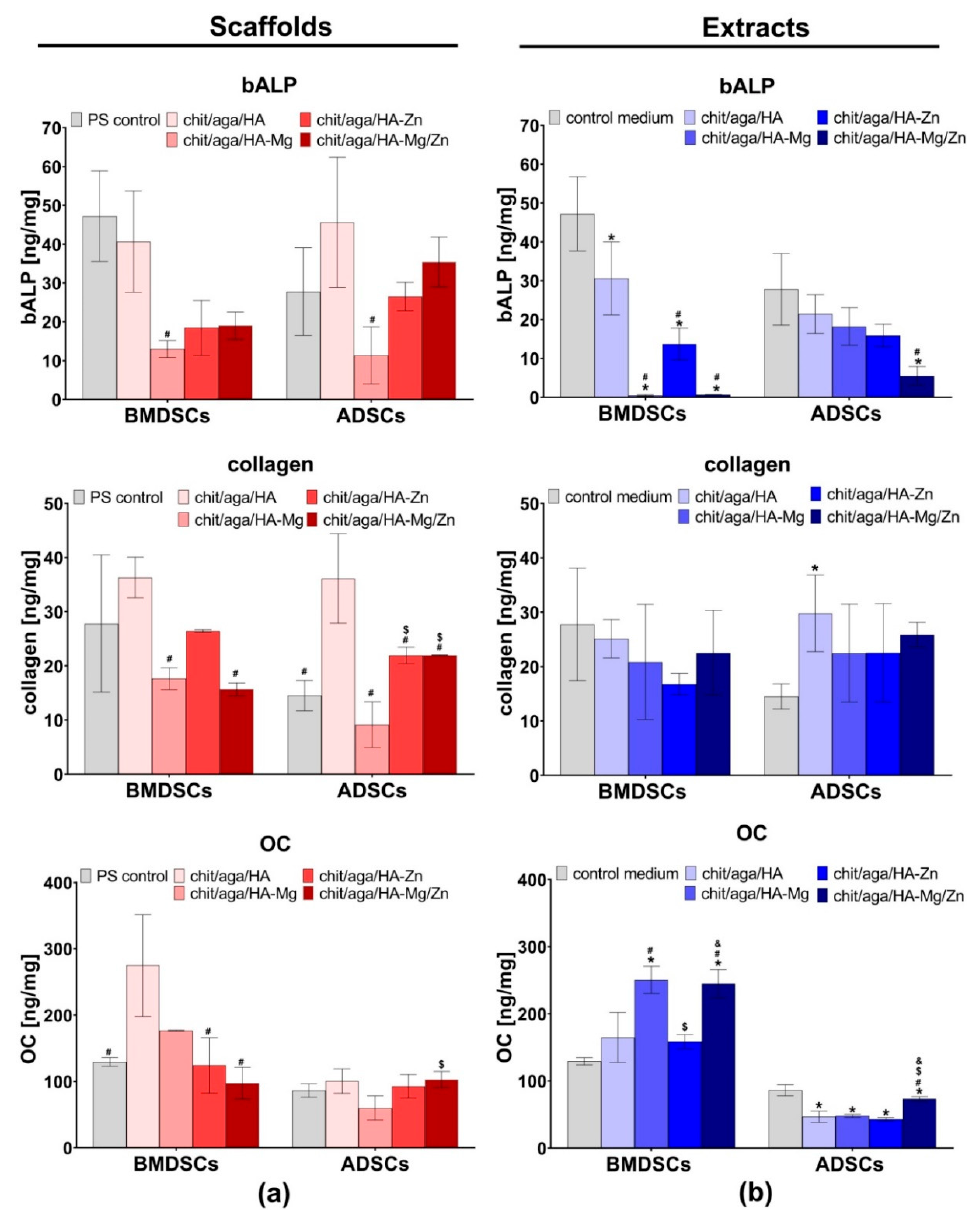
Figure 7. The level of osteogenic markers assessed by enzyme-linked immunosorbent assay (ELISAs): ( a ) level of markers in mesenchymal stem cells (MSCs) grown on the scaffolds (PS control, cells cultured in PS wells); ( b ) level of markers in MSCs cultured in PS wells in the presence of scaffolds extracts (control medium, cells maintained in osteogenic medium). The results were expressed as ng of marker per mg of total cellular proteins. * statistically significant results as compared to PS control / control medium, # statistically significant results as compared to chit / aga / HA, $ statistically significant results as compared to chit / aga / HA-Mg, & statistically significant results as compared to chit / aga / HA-Zn, P < 0.05, one-way ANOVA followed by Tukey’s